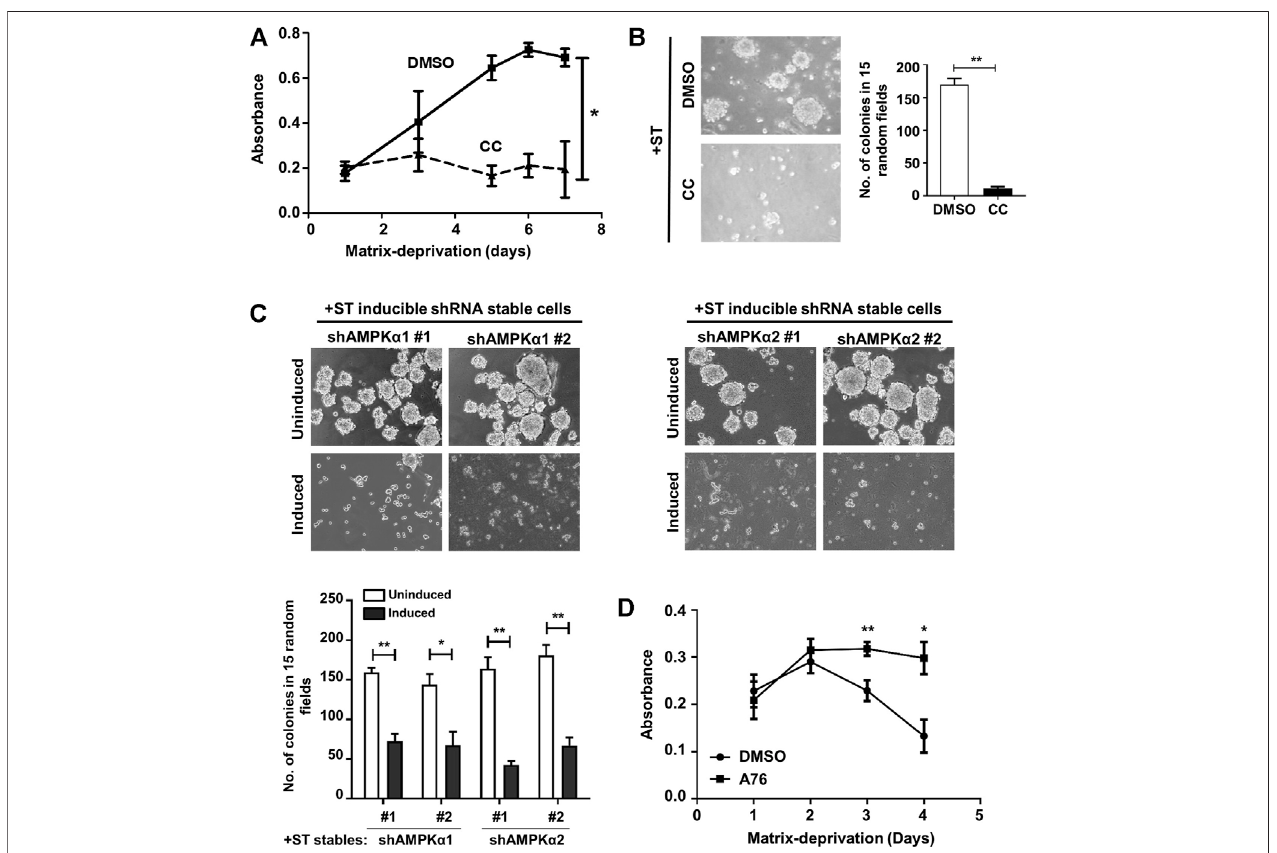
FIGURE2| AMPKactivationregulatessurvivalandproliferationofSTexpressingcells: (A) Matrix-deprived(Det)+STcellstreatedwitheithervehiclecontrol(DMSO) orAMPKinhibitor,compoundC(CC;10 μ M),for24 hwereculturedina96-wellultra-lowattachmentplatethatpreventscell-attachmentandsubjectedtoMTTassayat speci fi ed time periods. Absorbance was monitored for 7 days; n (cid:1) 4. Error bars represent mean ± SEM. (B) Cells as treated in (A) were subjected to colony formation in methylcellulose.Graphrepresentsthenumberofcoloniesin15random fi elds,countedafter15 days; n (cid:1) 3. (C) +STcellsstablyexpressingspeci fi edshRNAunder Tet-on inducible promoter were subjected to colony formation assay in methyl cellulose. Uninduced cells were used as control; 5 µg/ml doxycycline was used for induction. Graph represents the number of colonies in 15 random fi elds, counted after 15 days; n (cid:1) 3. (D) Matrix-deprived (Det) − ST cells treated with either vehicle control (DMSO) or AMPK activator, A-769662 (A76; 150 μ M), were subjected to MTT assay in a 96-well ultra-low attachment plate. Absorbance was monitored for 4 days; n (cid:1) 4. Error bars represent mean ± SEM.